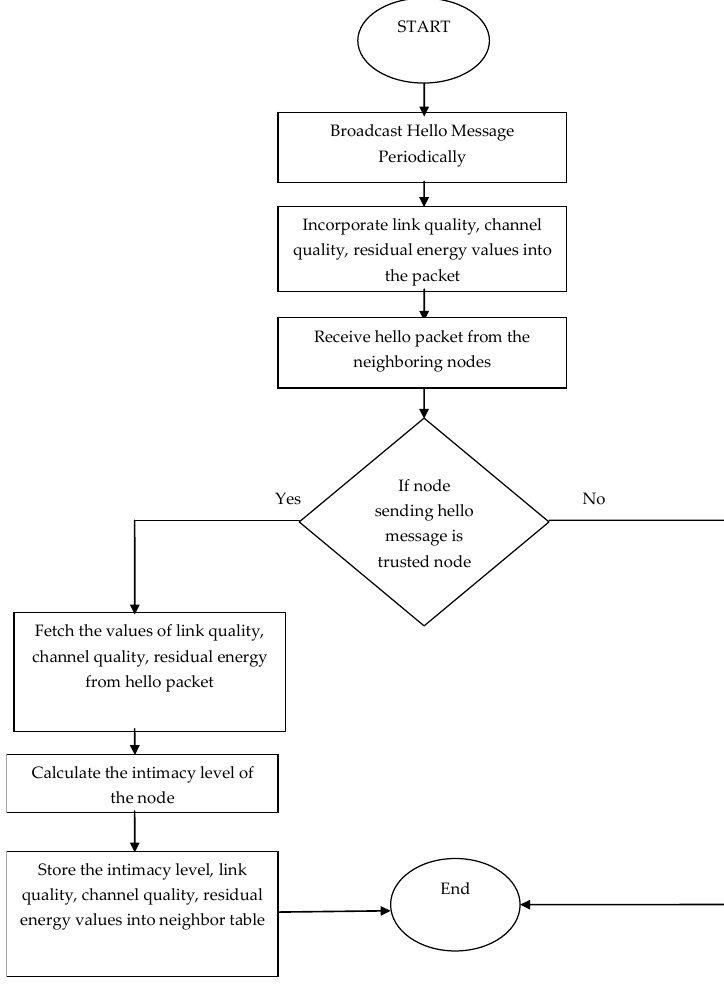
Figure 2. Trust recommendation using HELLO message exchange.